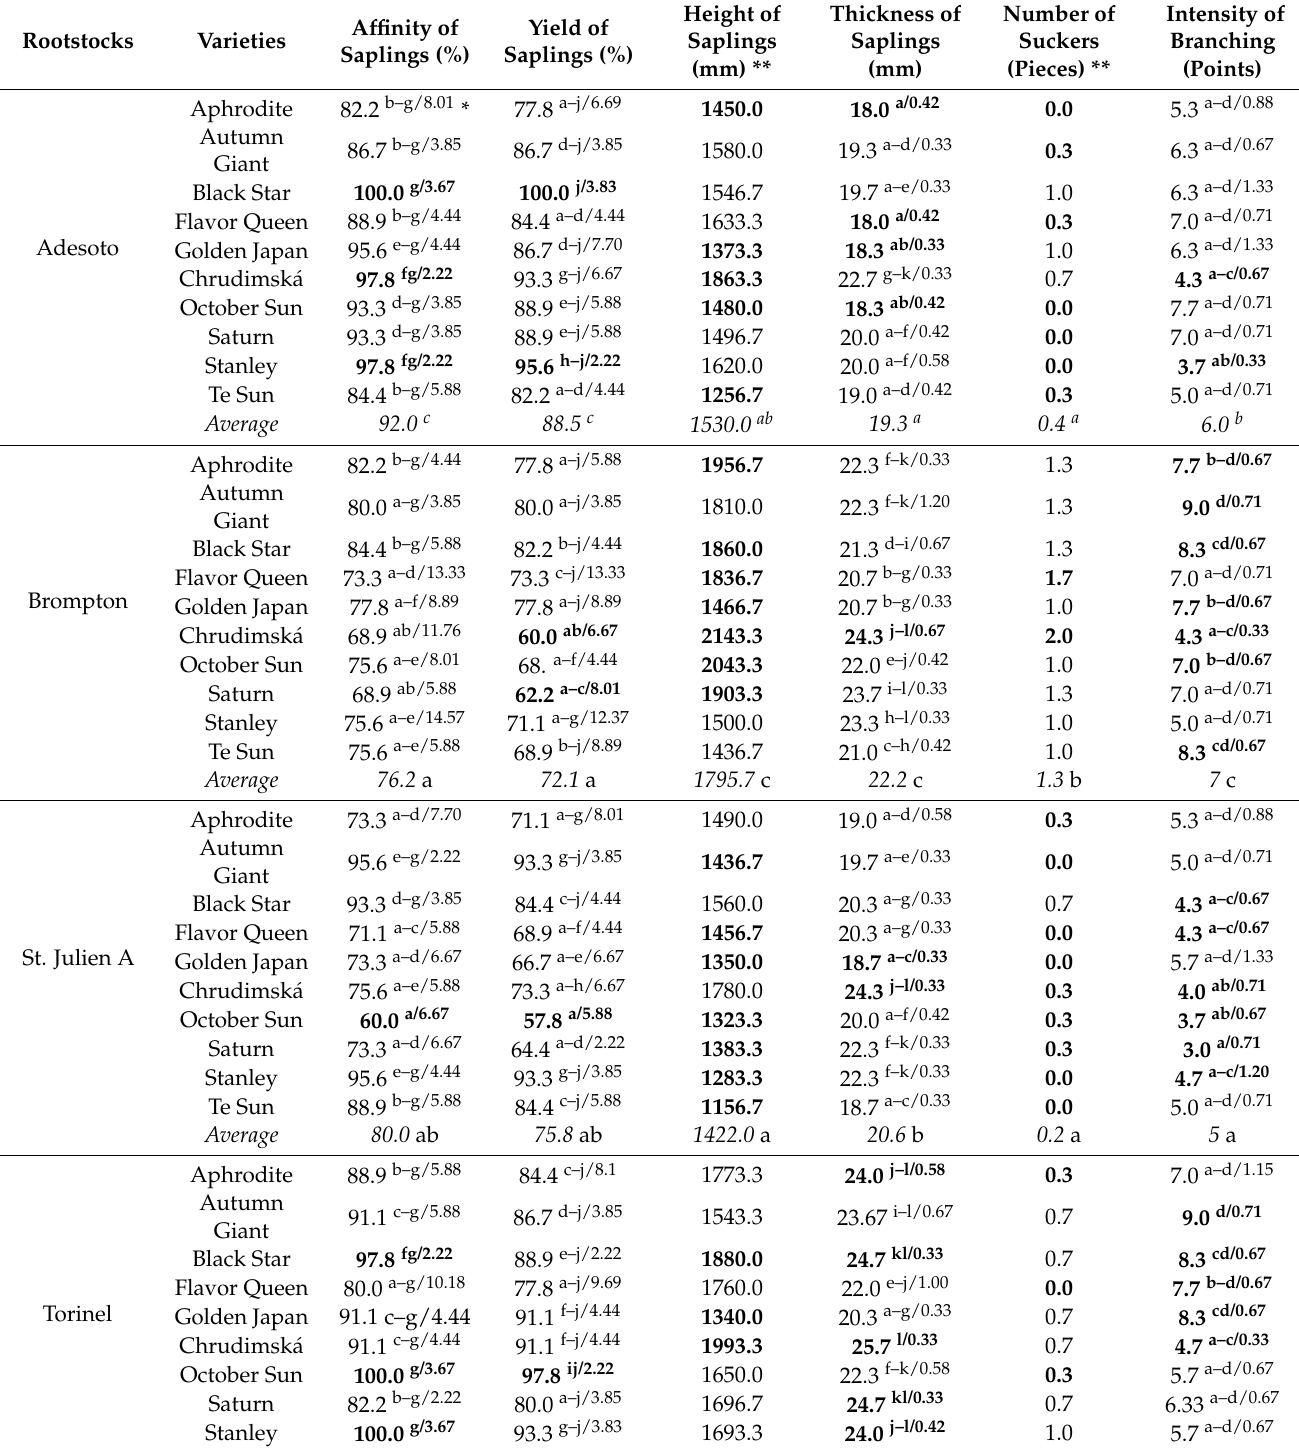
Table 2. Average trait values for rootstock–variety interactions and statistical significance regardless of